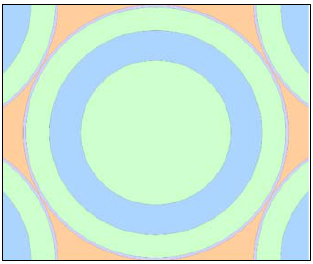
Figure 8. Natural circulation of fuel salt with U- Tube fixed inside a (vertical) fuel tube.